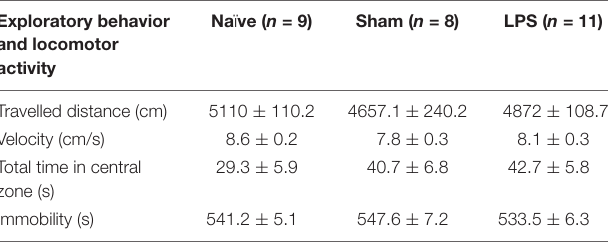
TABLE 1 | Open field test in adult animals after neonatal peripheral LPS challenge